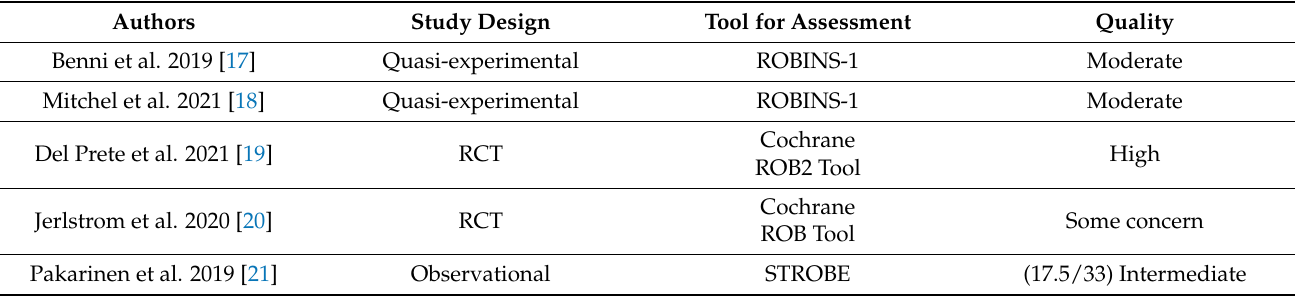
Table 2. Quality assessment of RCTs, quasi-experimental, and observational